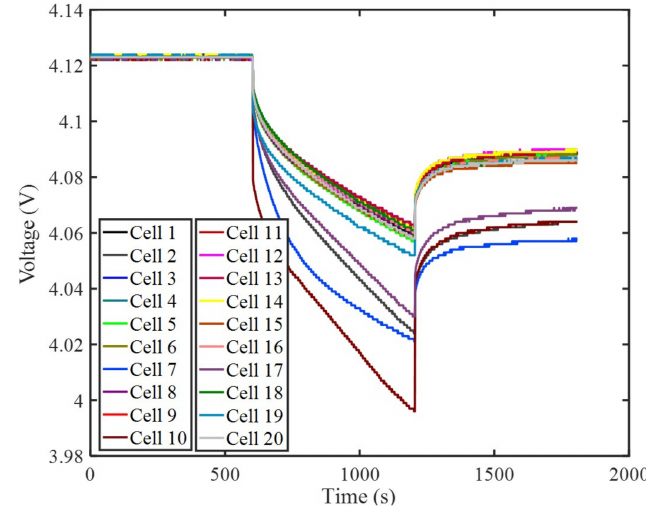
Figure 11. Voltage curves during